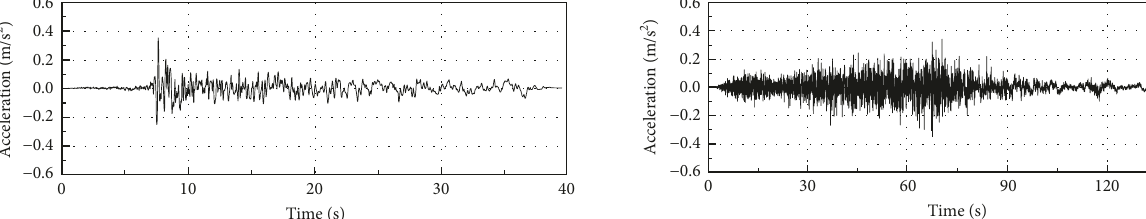
Figure 6: Earthquake acceleration time-history curve of intensity 7 frequently of Imperial Valley (transverse input).